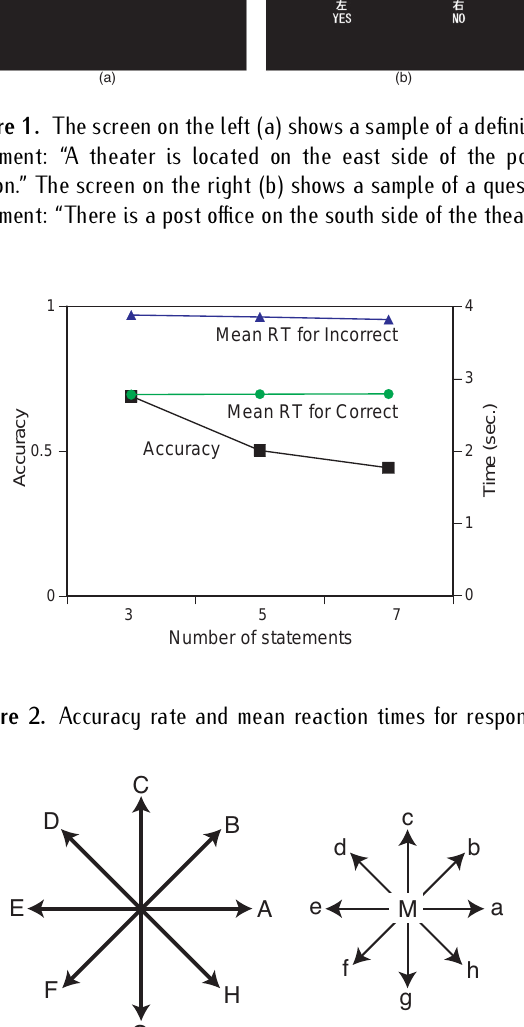
Figure 3. Eye movement categories: ’A’-’H’ (’a’-’h’) are directions of saccades (micro-saccades) and ’M’ is a fixation.